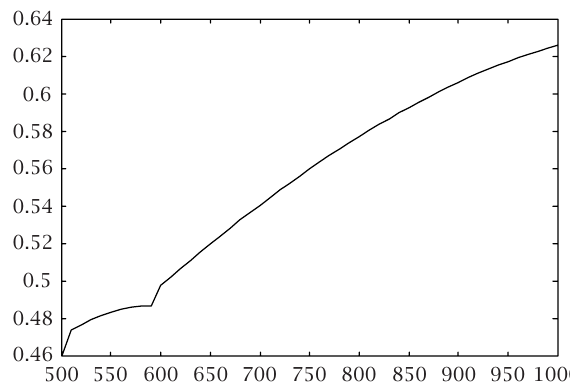
Figure 4.2. Torque distribution showing the second break in the Torque at Re ≈ 580.